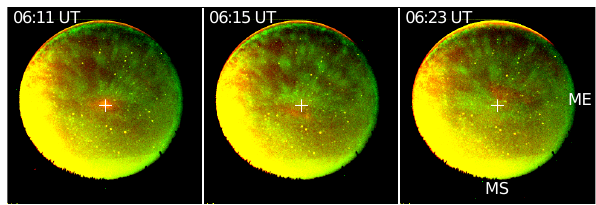
Fig. 10. Composite color (630.0, 557.7, and 427.8nm) image of F- region heating (red spot near center) blocked by hard precipitation (irregular green band) that appeared overhead during an experiment on 23 March 2004. Saturated colors represent an intensity of 200R. Note the red emissions continuing through a gap in the precipitation in the image for 06:47 UT.